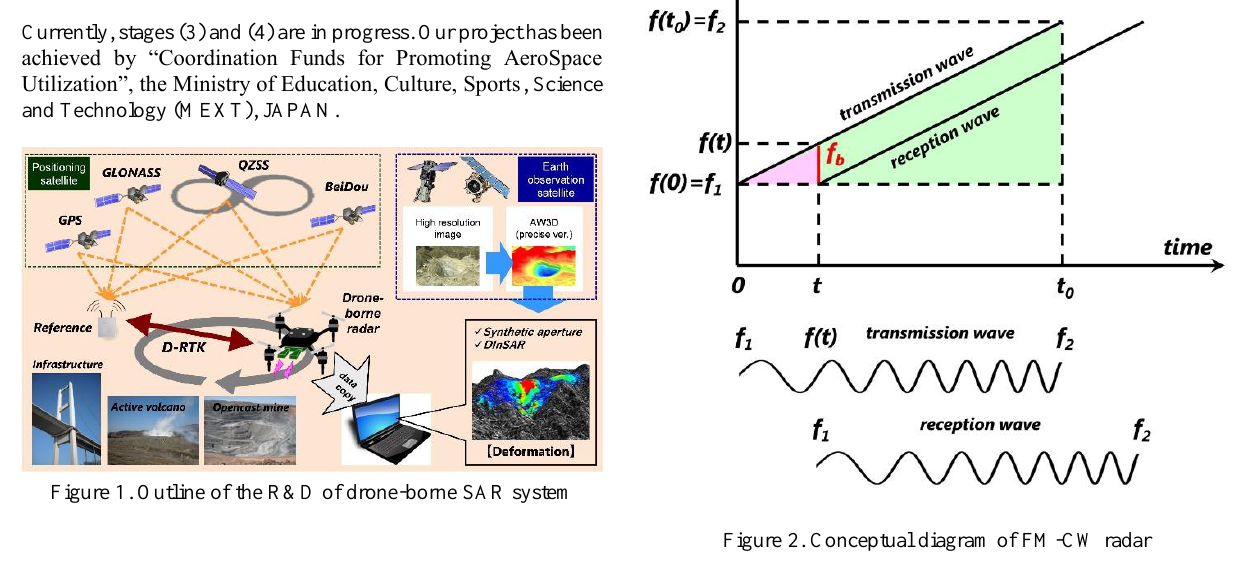
Figure 2. Conceptual diagram of FM-CW